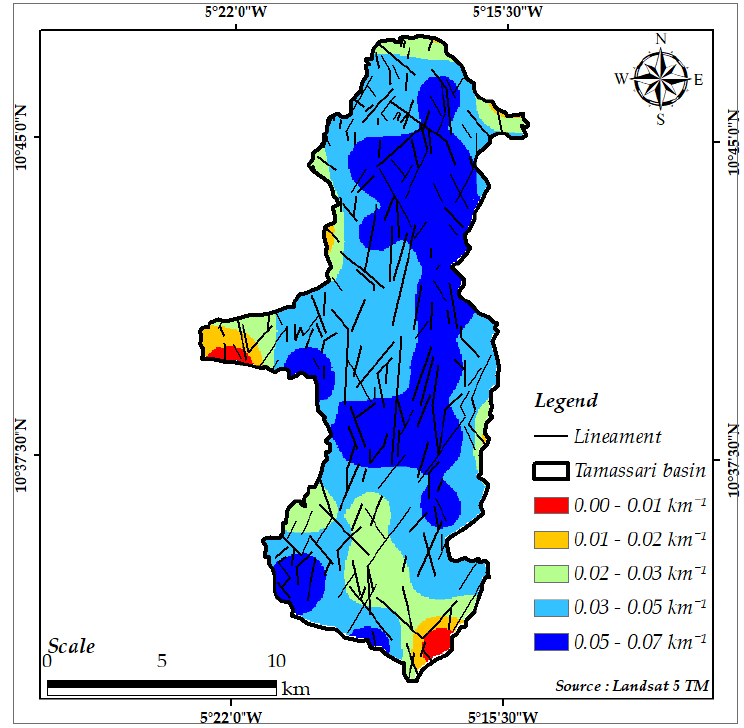
Figure 7. Lineament density mapping.